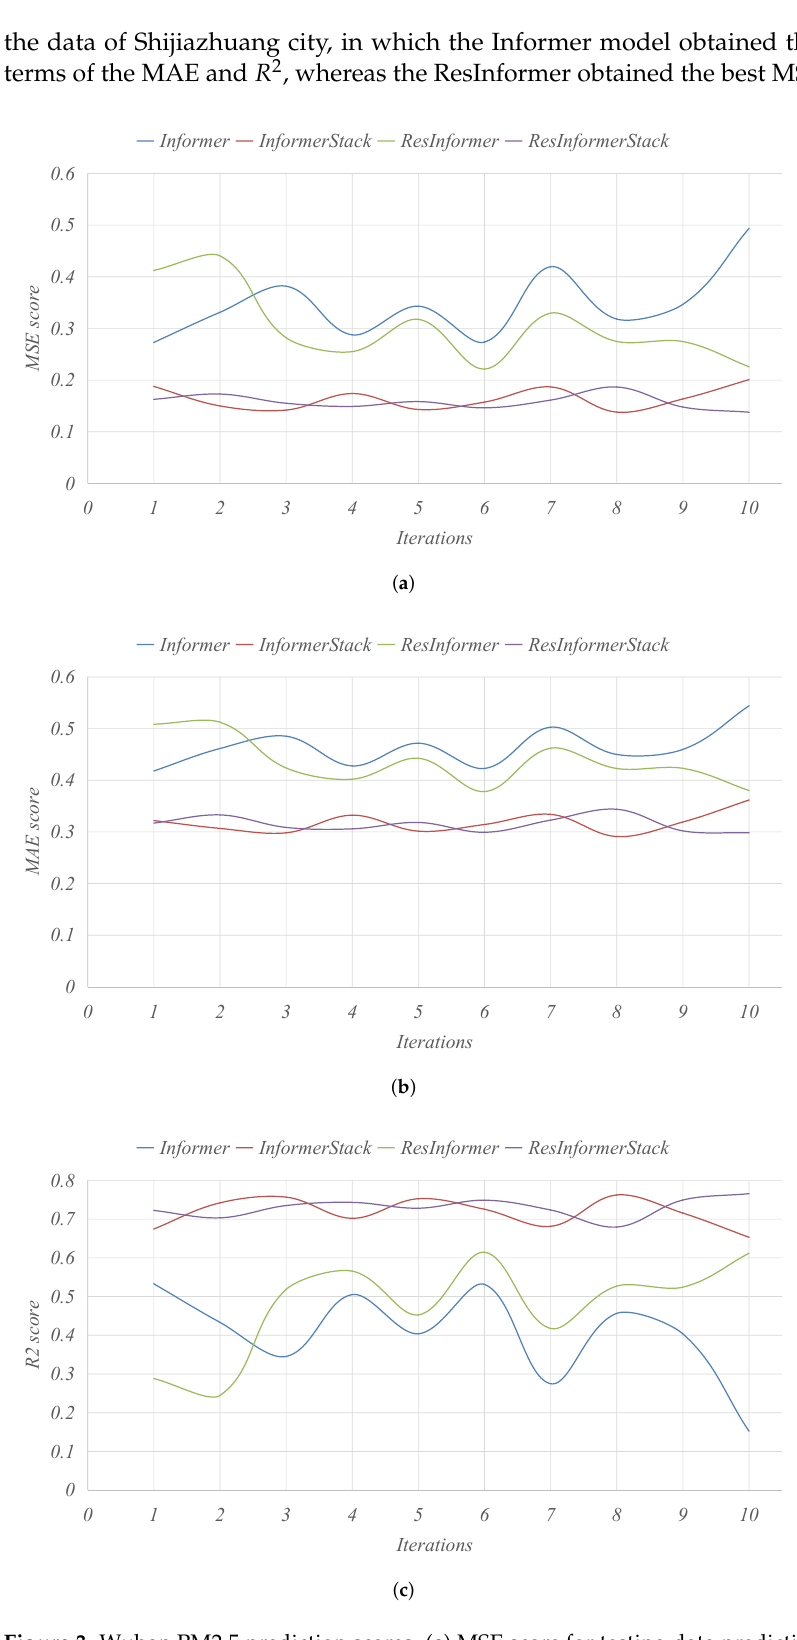
Figure 3. Wuhan PM2.5 prediction scores. ( a ) MSE score for testing data predictions; ( b ) MAE score for testing data predictions; ( c ) R 2 score for testing data